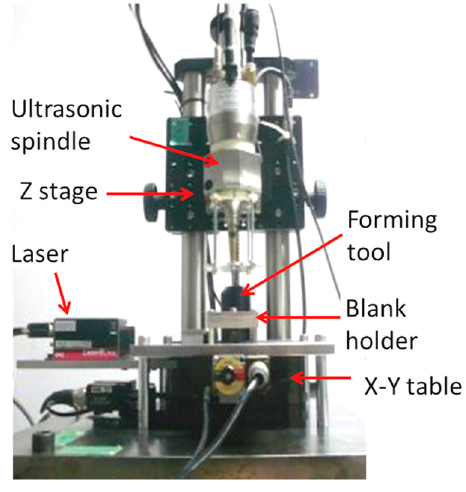
Figure 1. Desktop microforming machine.